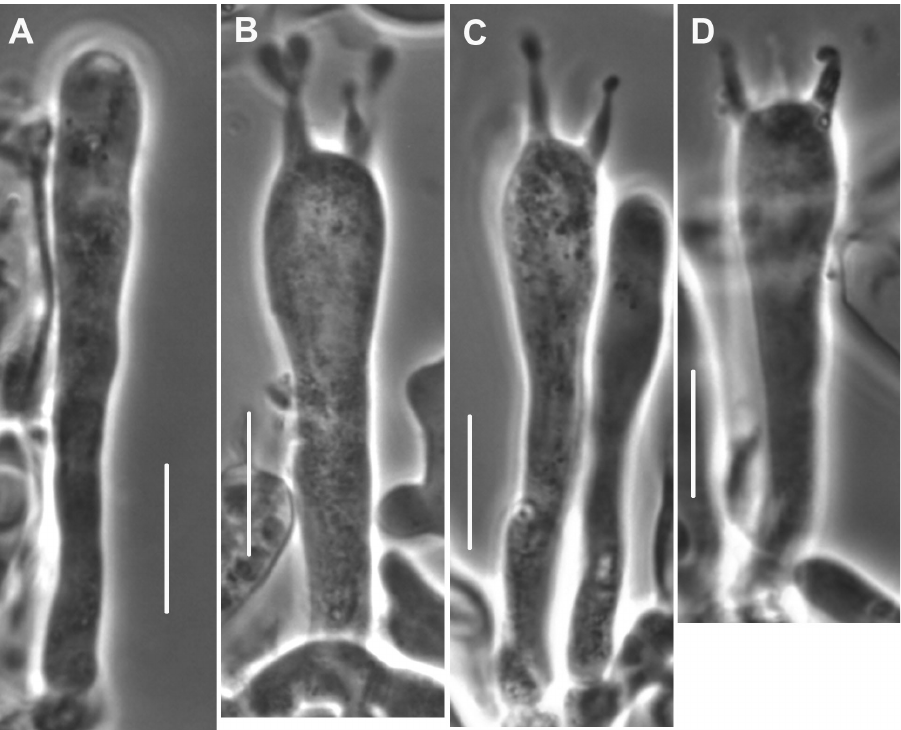
Figure 24. Mycetinis copelandii . Basidia. A Immature individual B–D Mature individuals. Standard bars = 10 µm. TFB 8084